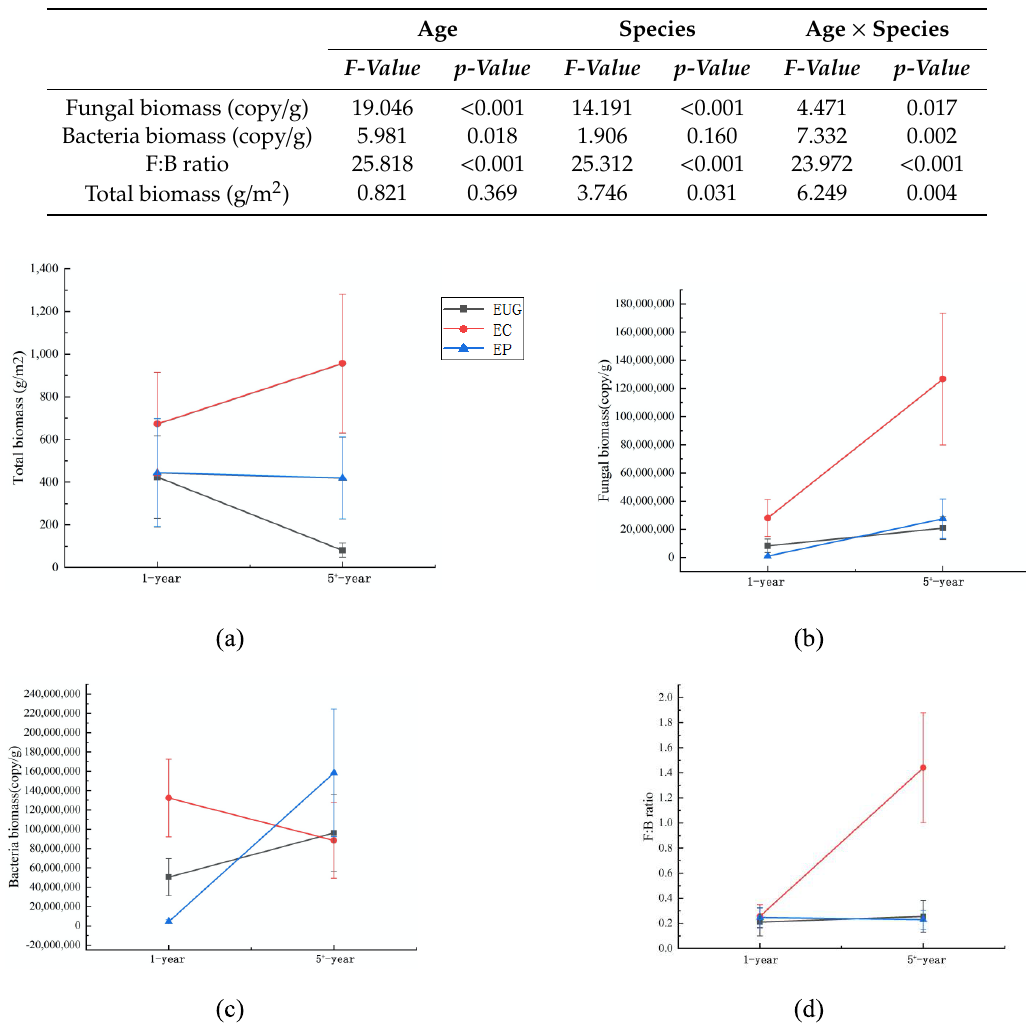
Figure 1. The soil total microbial biomass ( a ), fungal biomass ( b ), bacterial biomass ( c ) and fungi:bacteria ratio ( d ) in eucalyptus plantations with different ages and species. Abbreviations: EUG: E. urophylla×E.grandis ; EC: E. camaldulens ; EP: E. pellita .